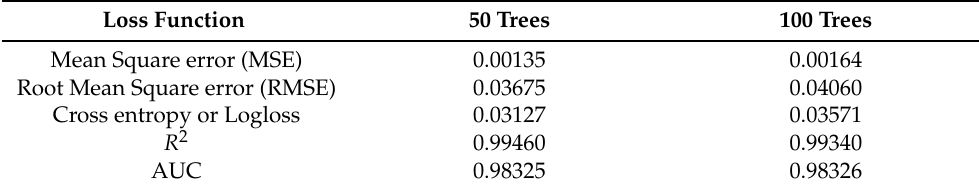
Table 5. Two Distributed Random Forest experiments’ results.